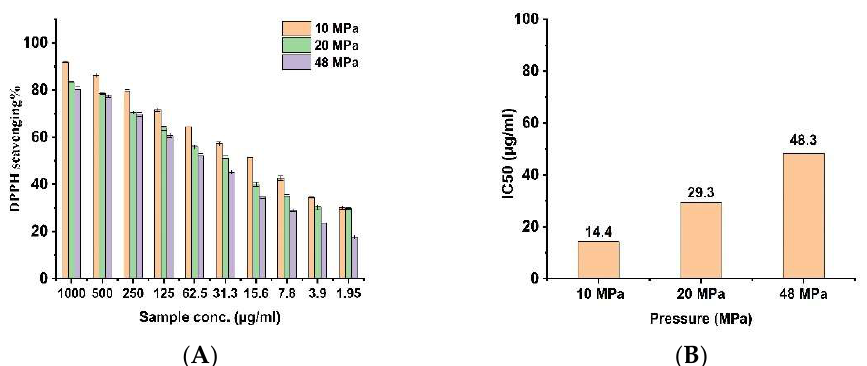
Figure 6. Antioxidant activity of SFE extracts of S. costus at different pressures using a DPPH assay (mean ± s. d, n = 3). ( A ). DPPH scavenging %. ( B ). IC50 value.